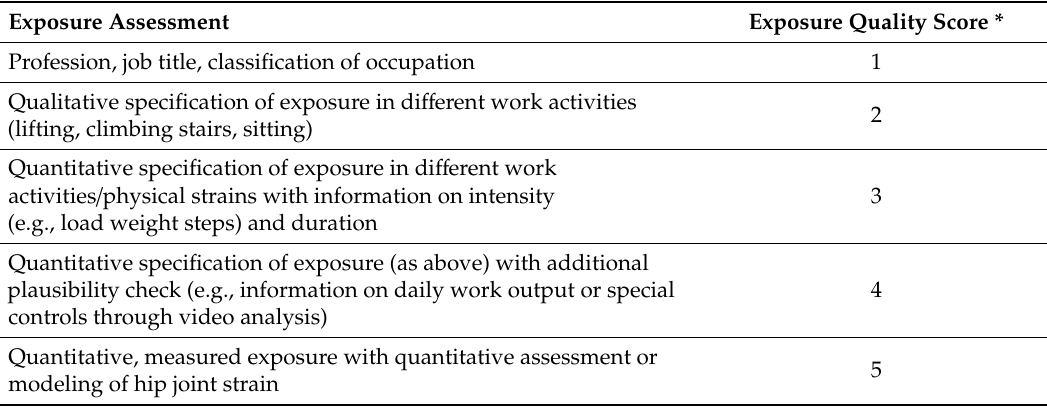
Table 2. Definition of quality for exposure assessment of studies on osteoarthritis of the hip (score 1–5) [5]. Exposure